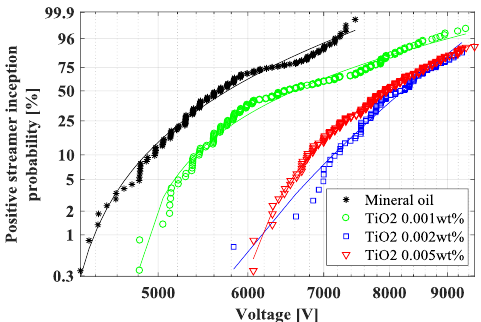
Figure 5. Streamer inception cumulative probability of TiO 2 nanofluids at different mass concentrations under positive polarity. The reference data of mineral oil is added for sake of comparison. The corresponding fitting Weibull functions are shown as solid lines.